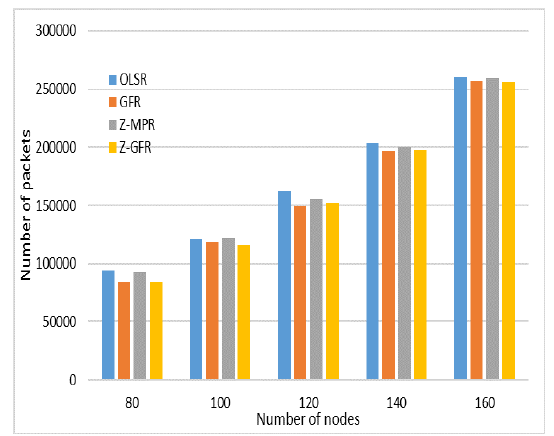
Figure 16. Total number of packets received at the MAC layers of nodes.